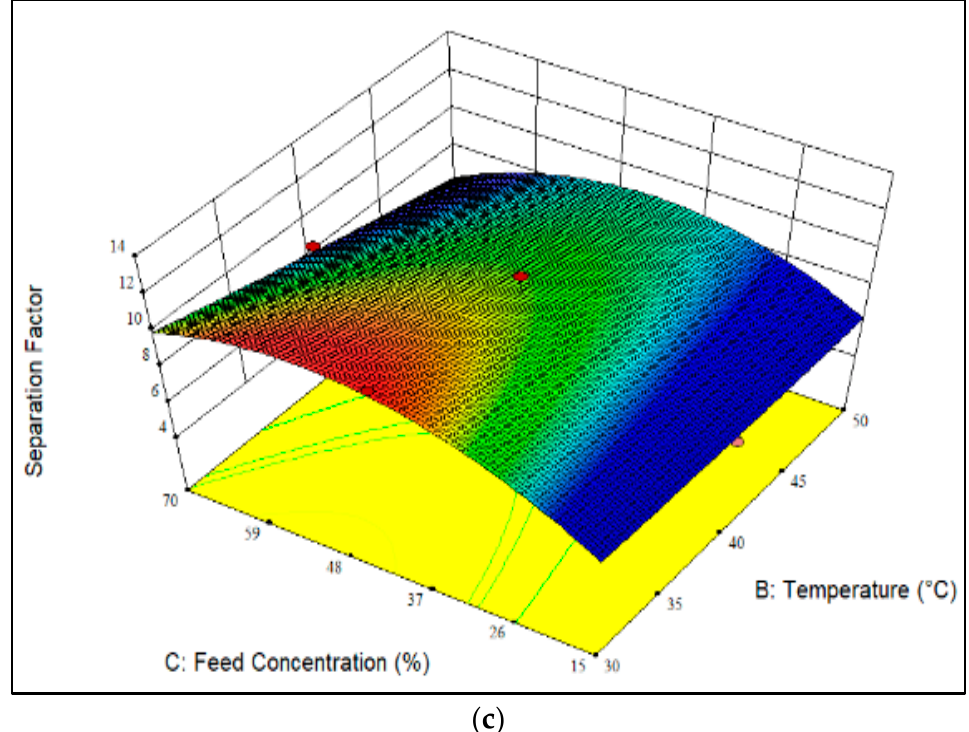
Figure 3. 3D surface of the CO2/CH4 separation factor as a function of feed pressure, CO2 feed concentration and temperature at ( a ) CO2 feed concentration of 42.5 mol%, ( b ) temperature of 40 °C and ( c ) feed pressure of 8 bar. (The darker colour (red) represents higher membrane performance whereas the lighter color (blue) indicates lower membrane performance.)